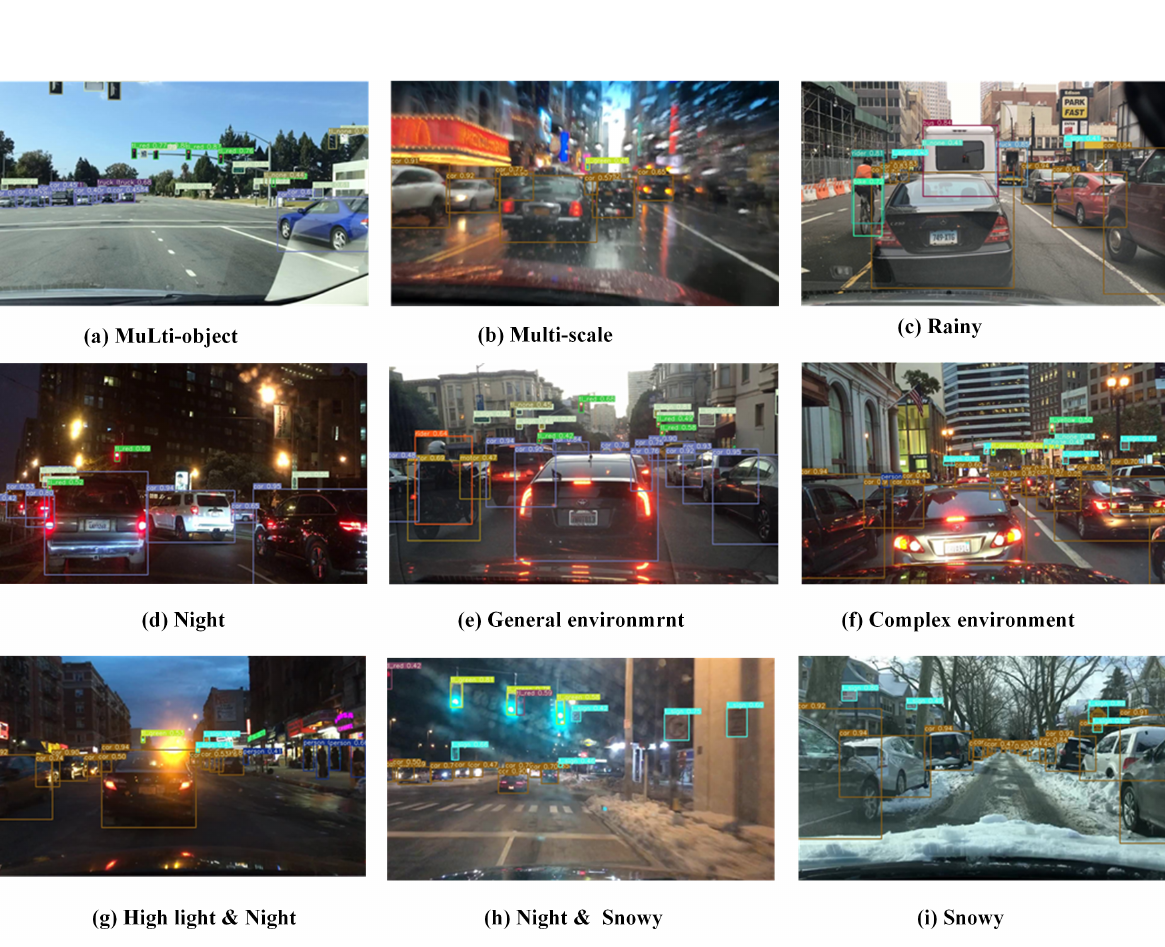
Fig. 5. Performance of our model under complex traffic